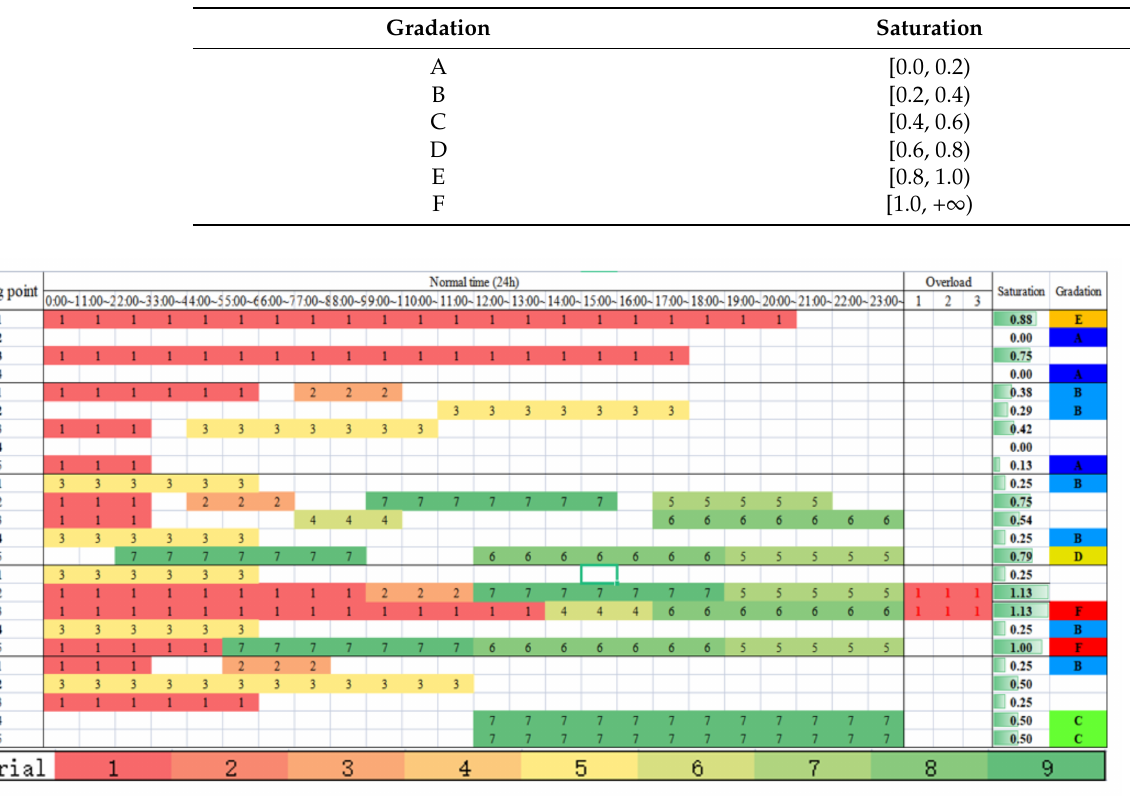
Figure 10. Space-time distribution map of